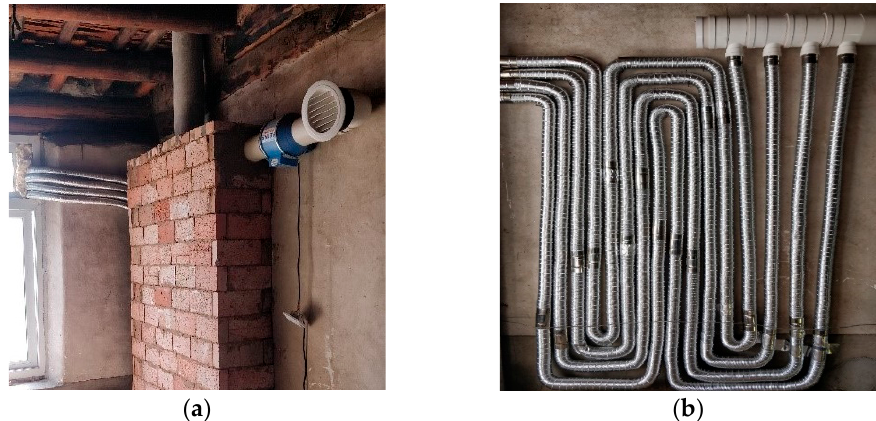
Figure 4. FGFAHE experiment bench: ( a ) experiment bench’s appearance, ( b ) duct arrangement.